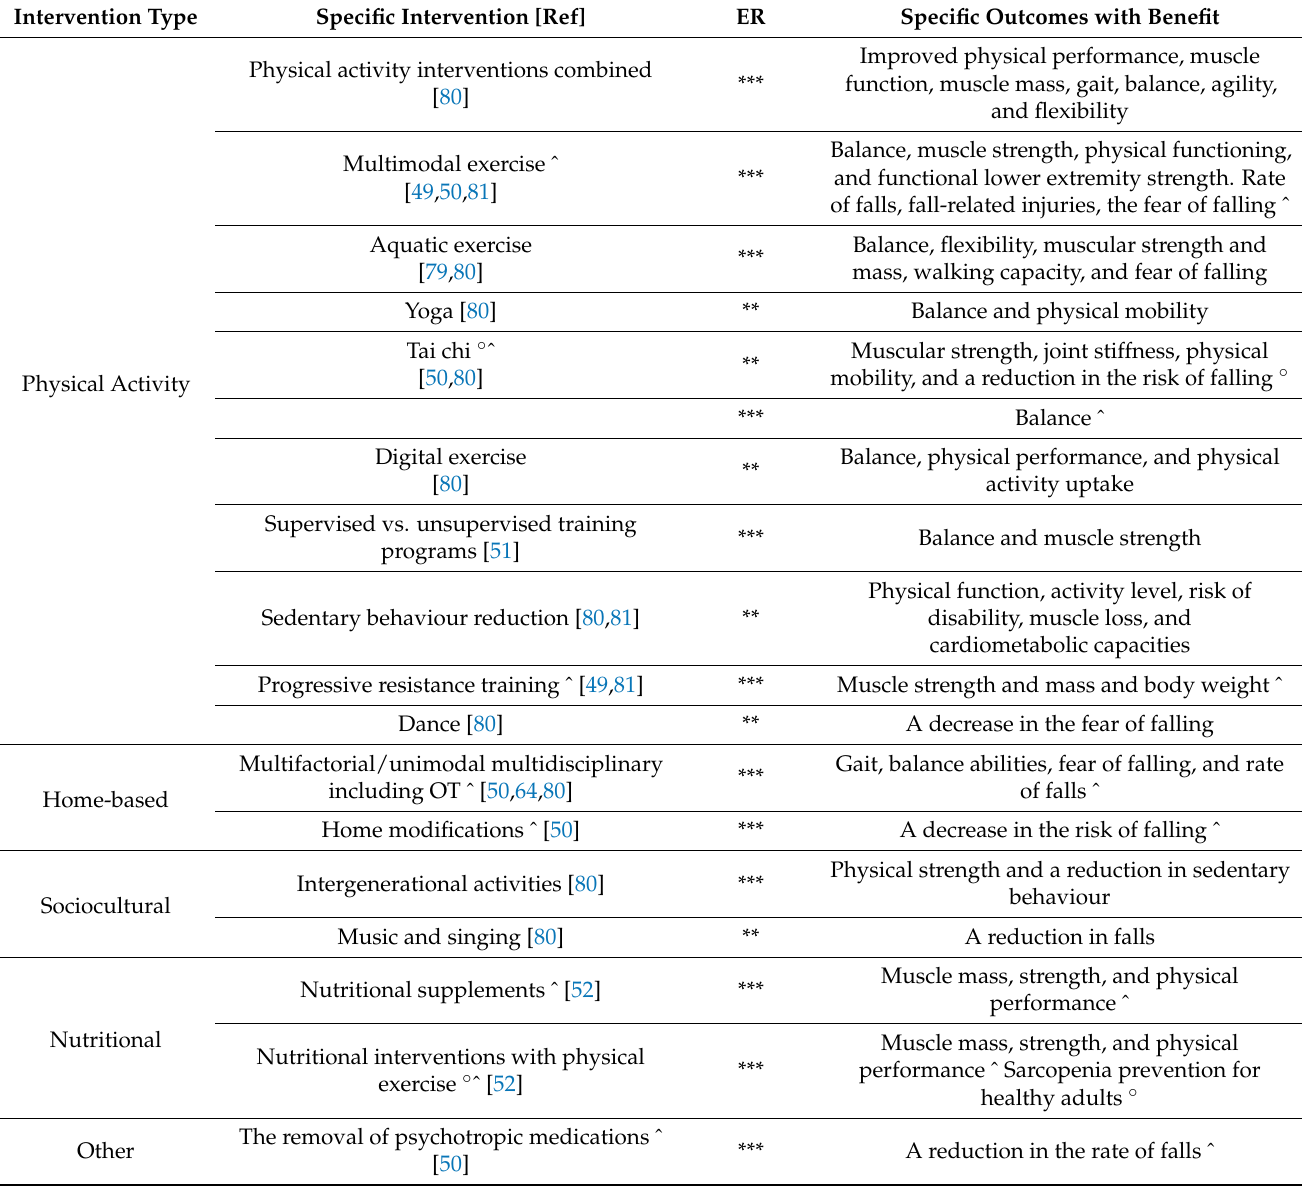
Table 2. Identified interventions for locomotor